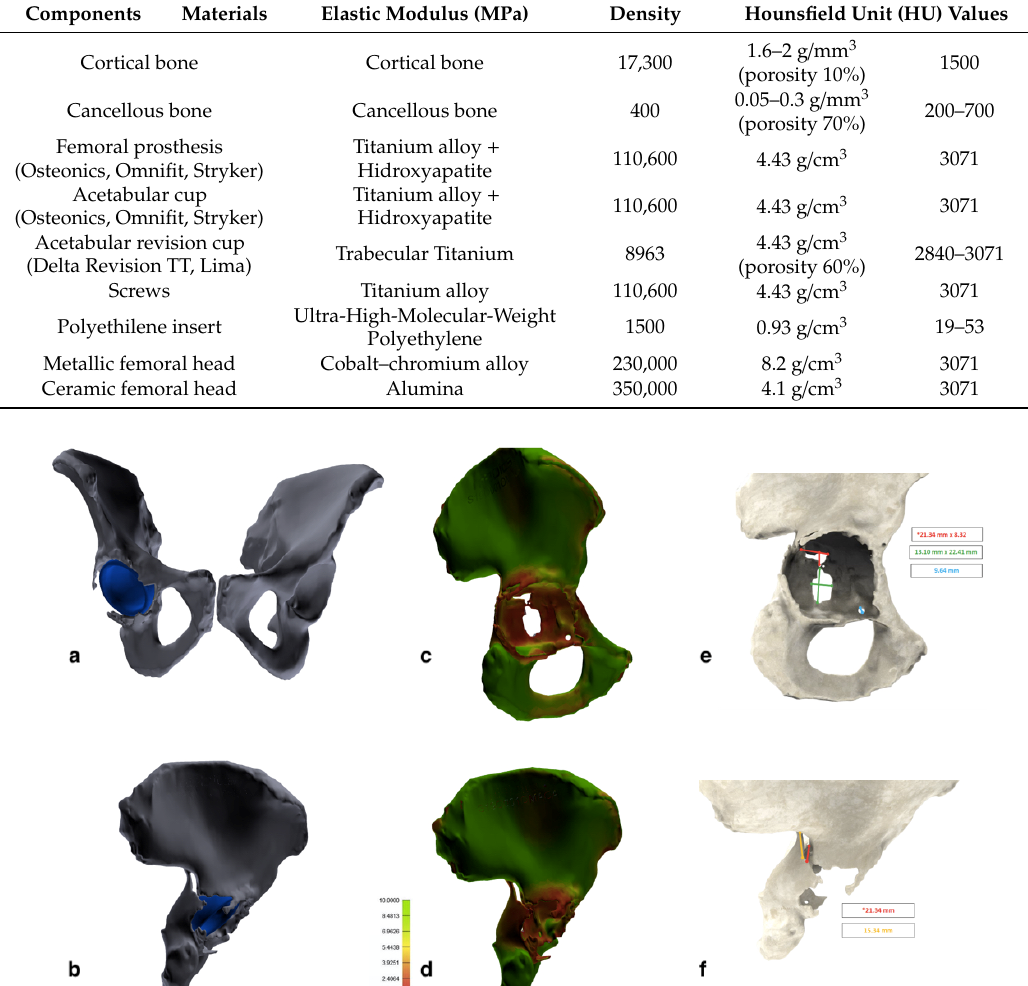
Table 1. Mechanical properties of materials involved in the CT scan analysis and segmentation of Case 1 [16,17].